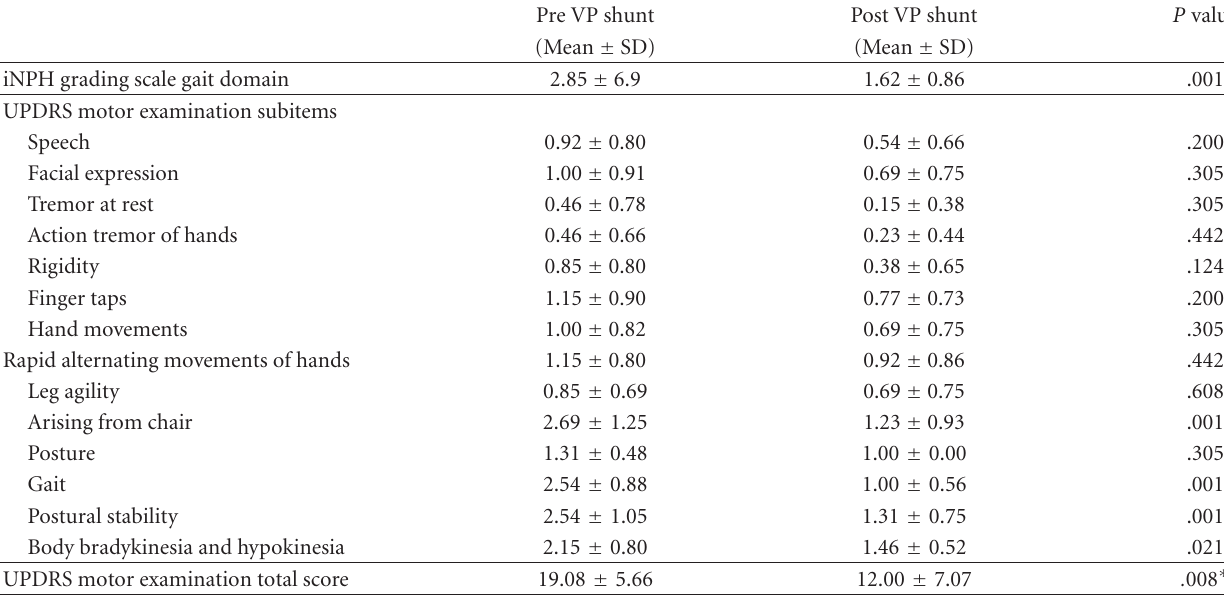
Table 1: Comparison between the grades of the Parkinsonian features before and after ventriculoperitoneal shunt operation.